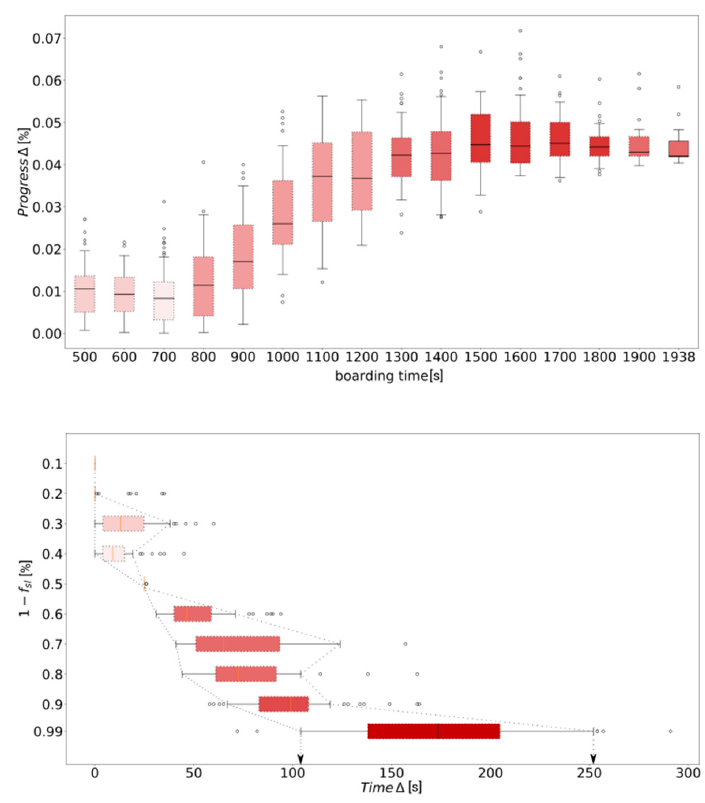
Figure 6. Scenario A ( random input— random prediction)—progress ( above ) and time ( below ).